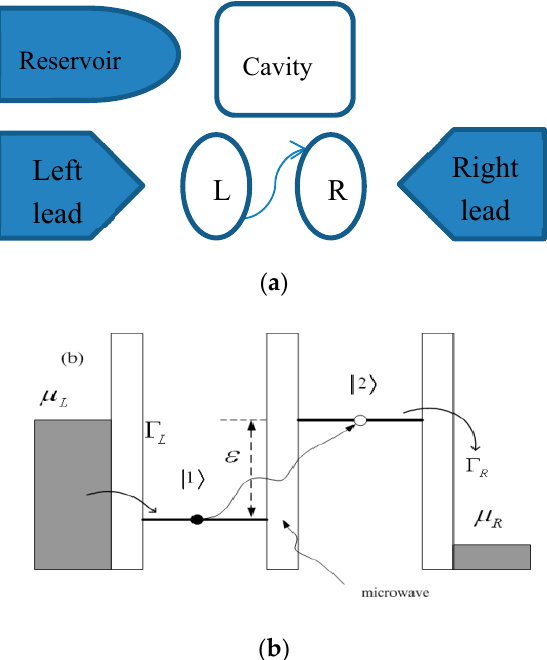
Figure 1. ( a ) The diagram shows the double quantum dots (DQDs) connected to symmetric leads: the left electrode is the electron source, and the right is the drain; between the two dots, a bias voltage is added. The left quantum dot is coupled with a microwave cavity by capacitive coupling. The level di ff erence of the two dots is (cid:125) , and the electron jumping from the left dot to the right is driven by an external alternating current (AC) microwave field of frequency ω d between the two dots. ( b ) An electron tunnels from the source to the left quantum dot and is driven to the right dot by the microwave field, finally tunneling to the drain ( µ L > µ R ).